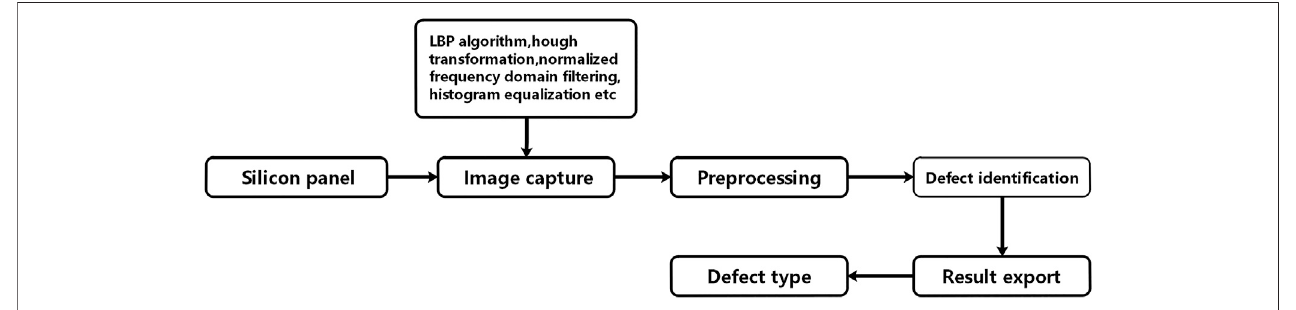
FIGURE 1 | Silicon panel detection process.